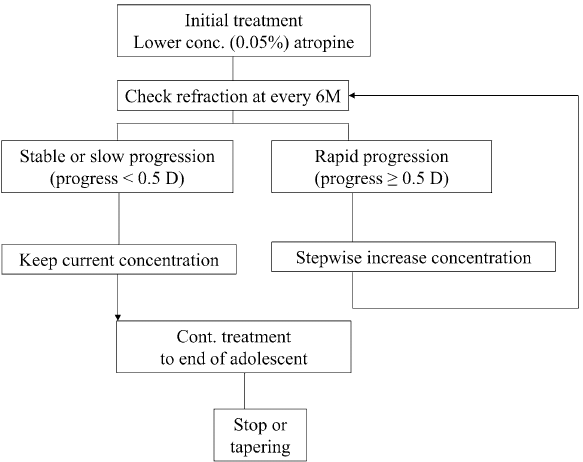
Figure 1. Protocol of stepwise low concentration of atropine